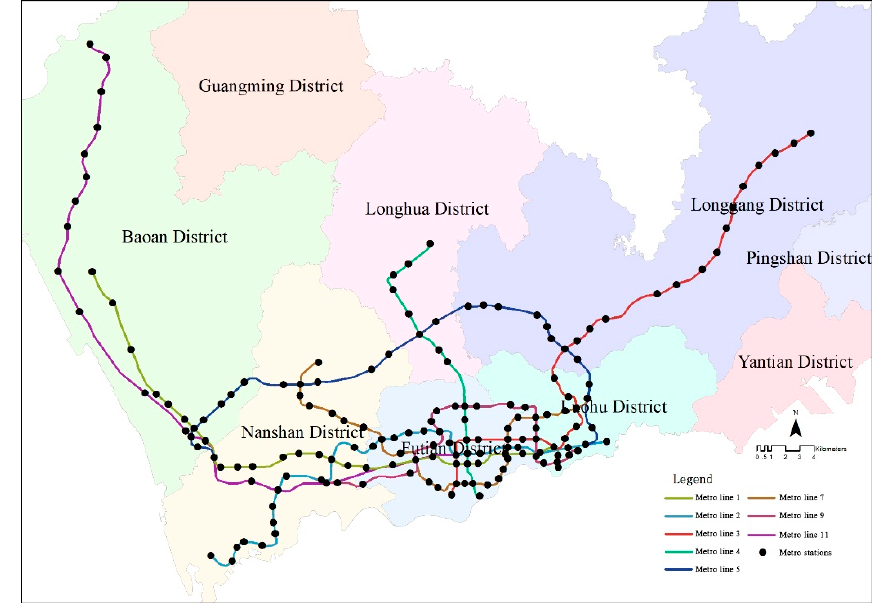
Figure 1. Shenzhen metro lines and stations.